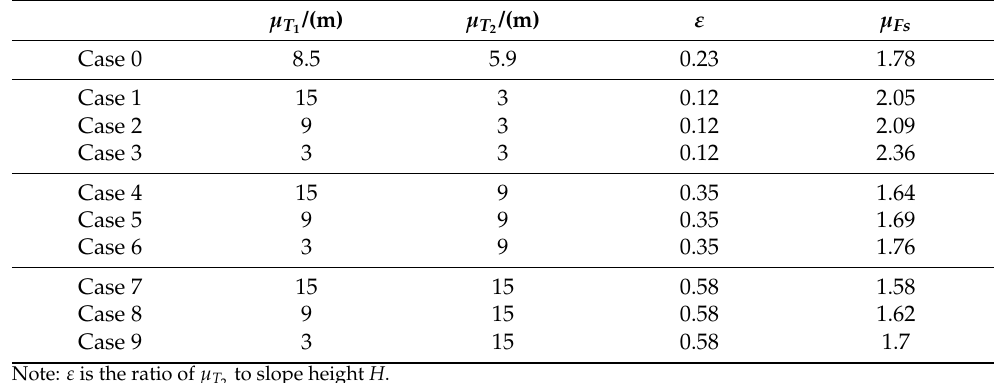
Table 4. Statistical table of the mean trace length and mean stability.